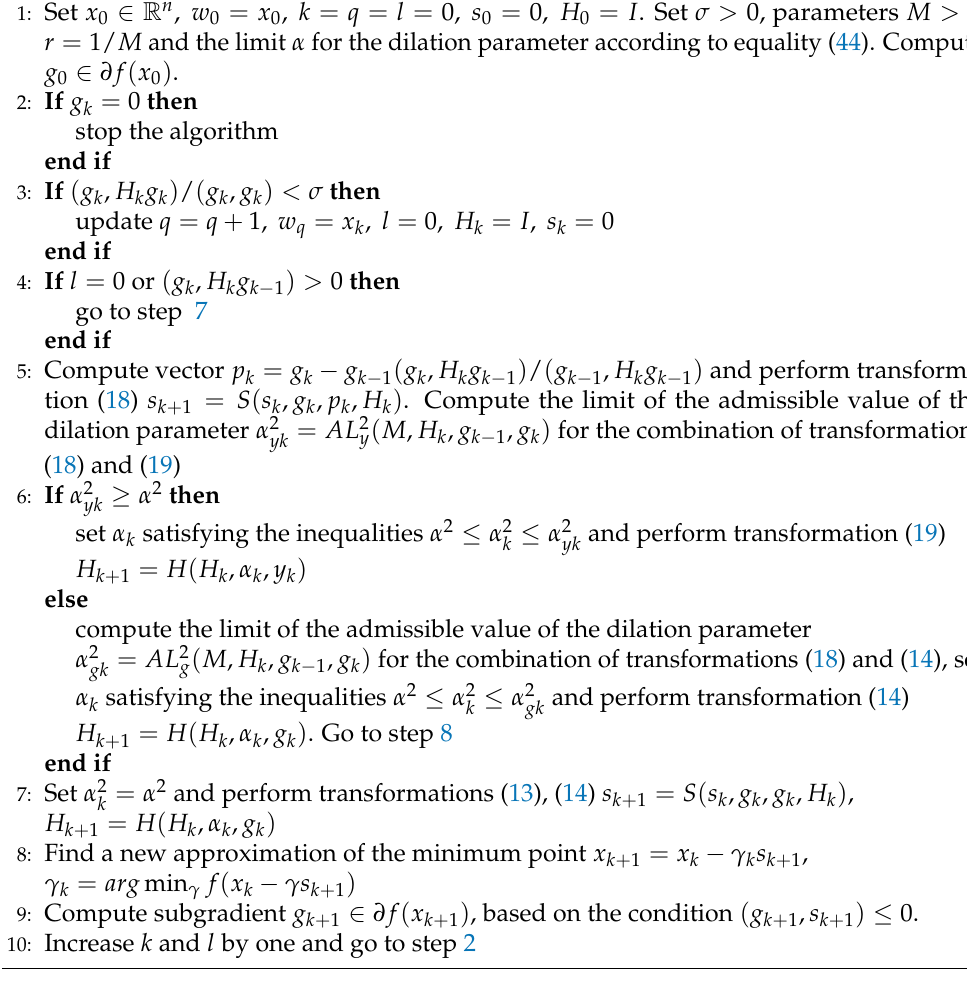
Algorithm 2 RA ( α )